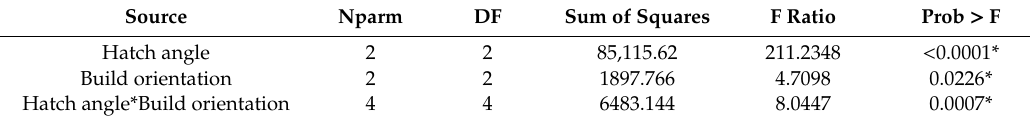
Table 10. E ff ects table for flow stress at 35% plastic strain ( α =